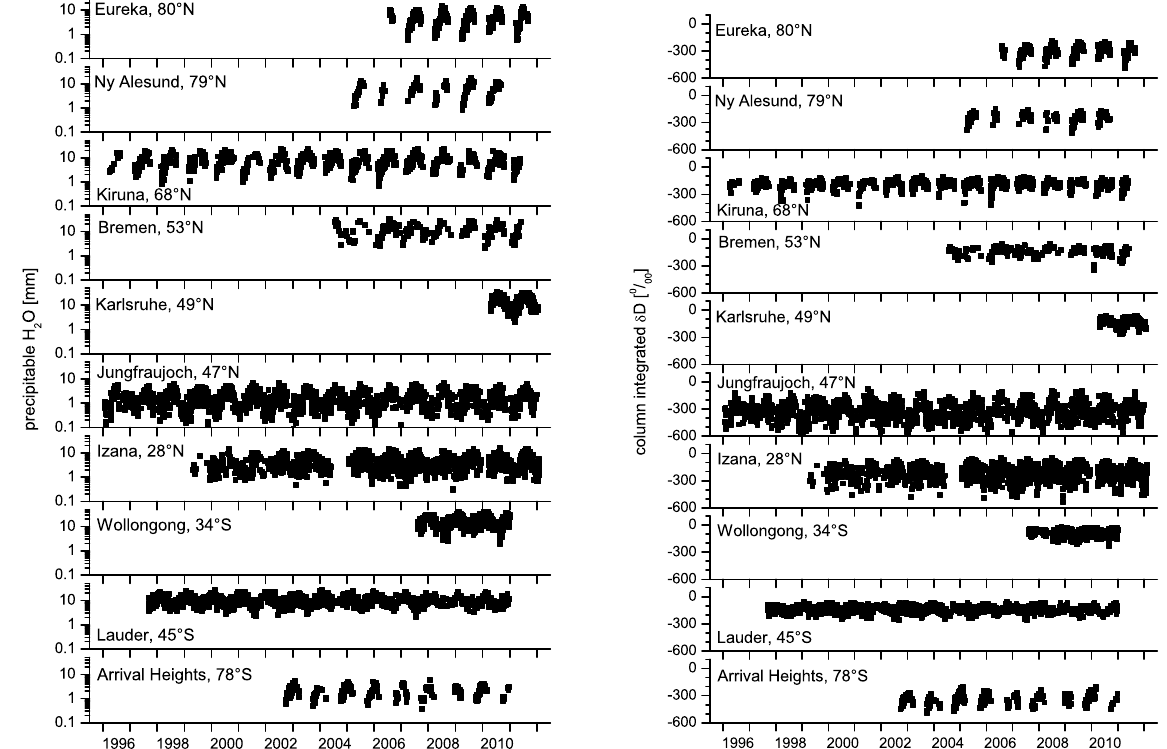
Fig. 12. Time series of column integrated H 2 O (left panel) and δ D (right panel) as currently available at the ten ground-based remote sensing sites that participate in MUSICA.